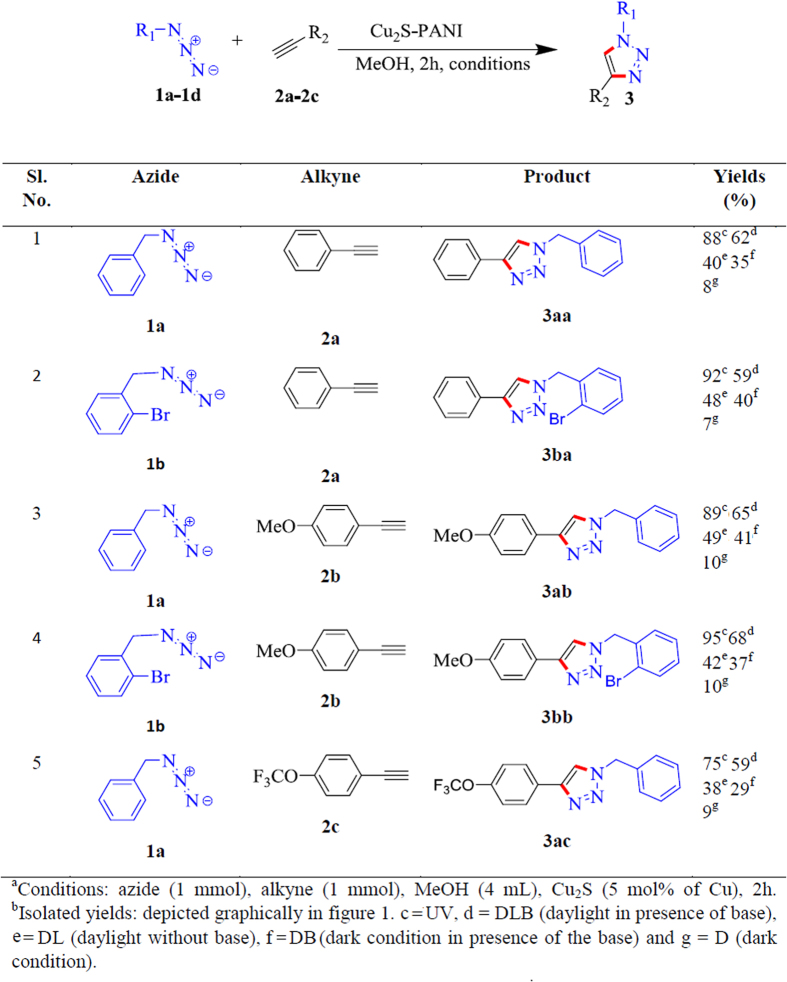
Optimization of Photonic effect and effect of base on click productsa,b.